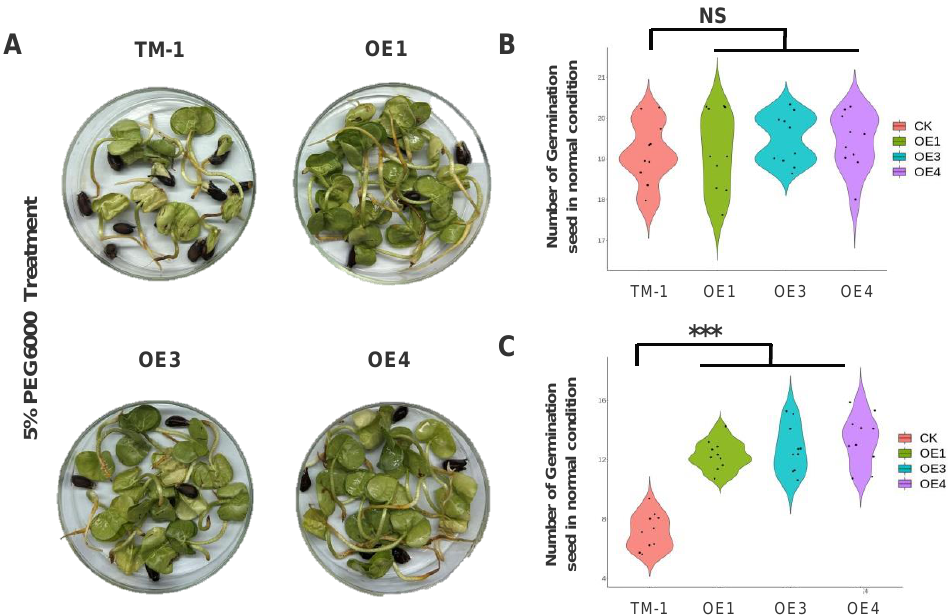
Figure 3. Drought treatment and germination rate of overexpression com58276 cotton seeds. ( A ) Germination of TM-1 with OE1, OE3, and OE4 cotton seeds under 5% PEG6000 treatment. ( B ) The number of germinating seeds under normal conditions. ( C ) The number of germinating seeds after PEG6000 treatment. (NS (no significance), p > 0.05, *** p < 0.001, Dunn’s test).